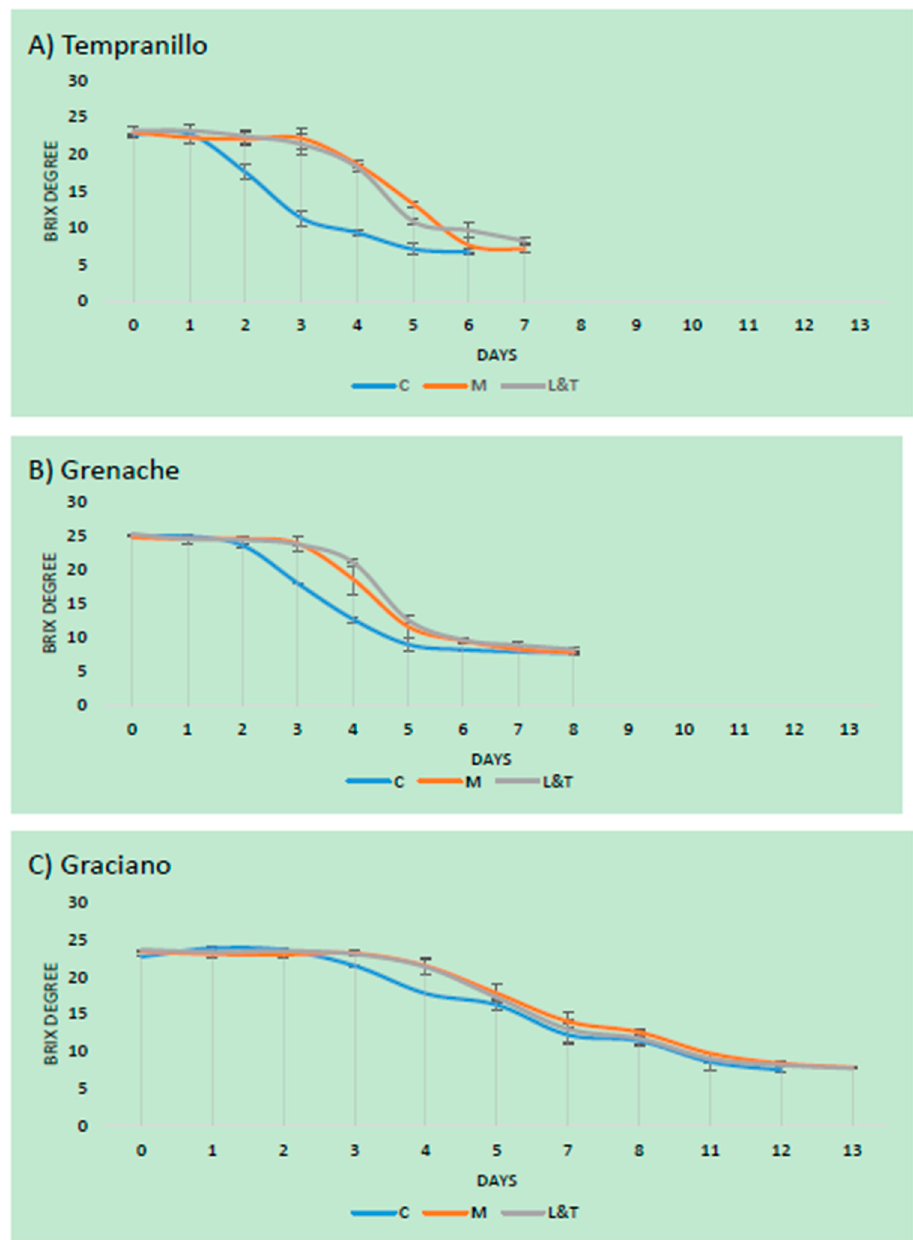
Figure 3. Brix degree measurement during alcoholic fermentation of control (C) samples and samples early inoculated with M. pulcherrima (M) and with a mix of L. thermotolerans and T. delbrueckii (L&T); ( A )Tempranillo, ( B ) Grenache and ( C ) Graciano. ( A )Tempranillo, ( B ) Grenache and ( C )